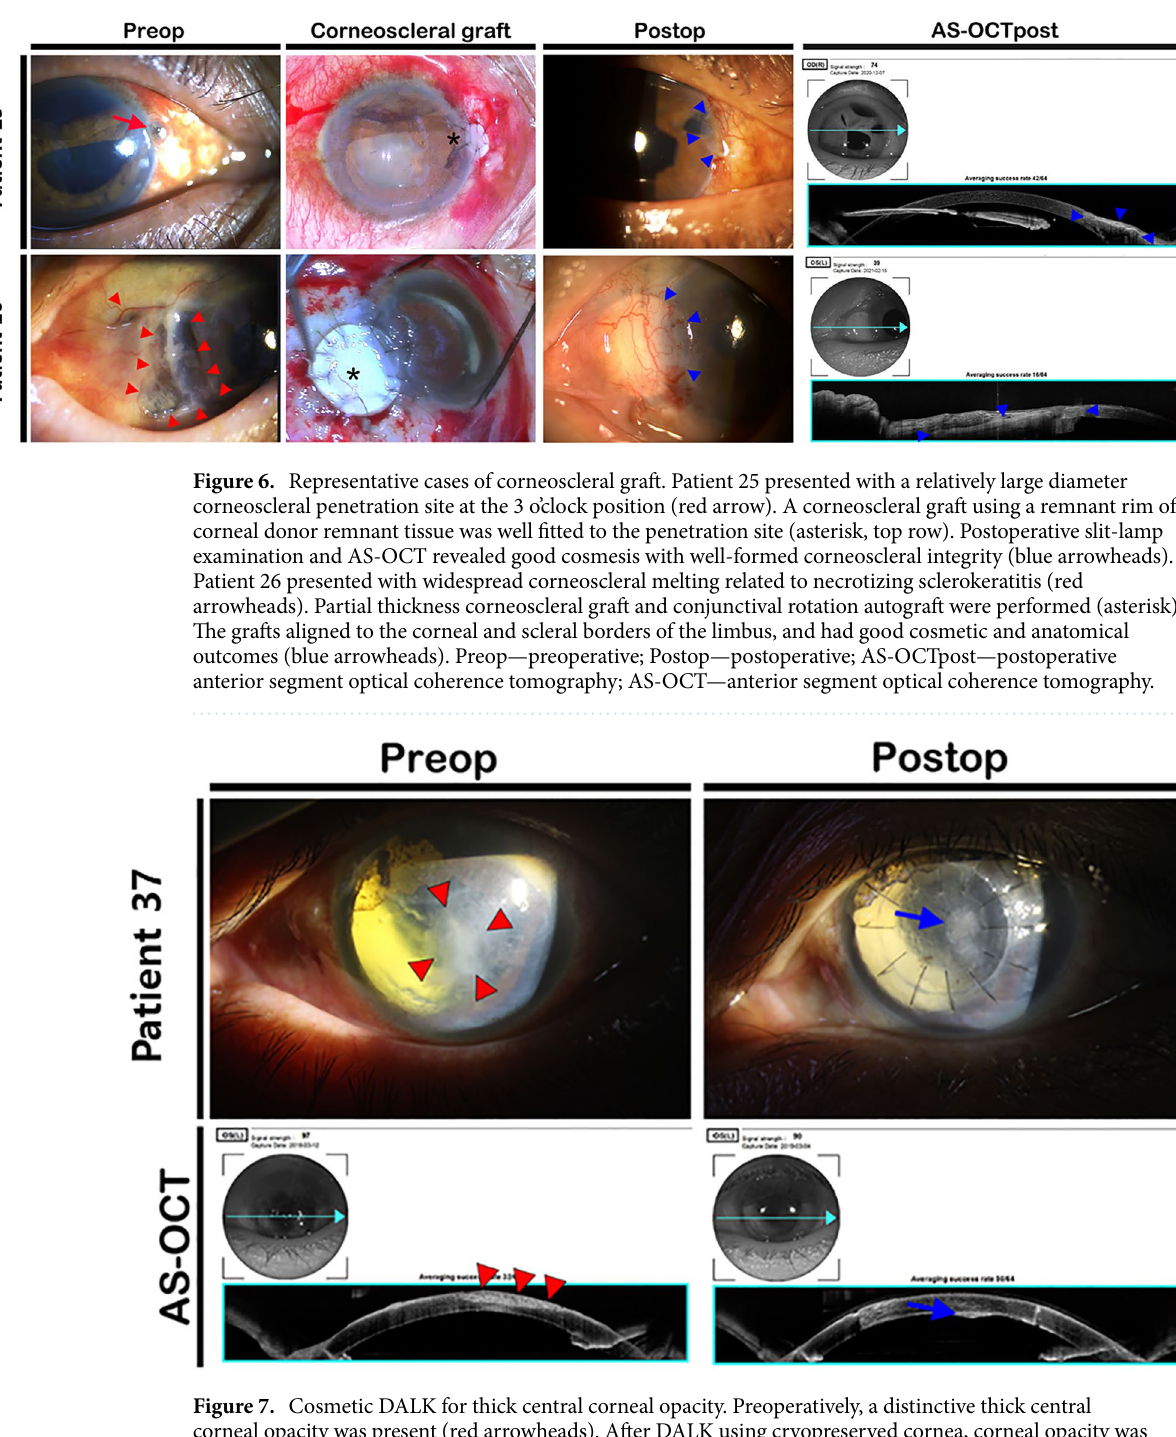
Figure 7. Cosmetic DALK for thick central corneal opacity. Preoperatively, a distinctive thick central corneal opacity was present (red arrowheads). After DALK using cryopreserved cornea, corneal opacity was significantly decreased. A thin opacity was observed near the Descemet membrane, but corneal clarity was significantly improved. Preop—preoperative; Postop—postoperative; AS-OCT—anterior segment optical coherence tomography; DALK—deep anterior lamellar